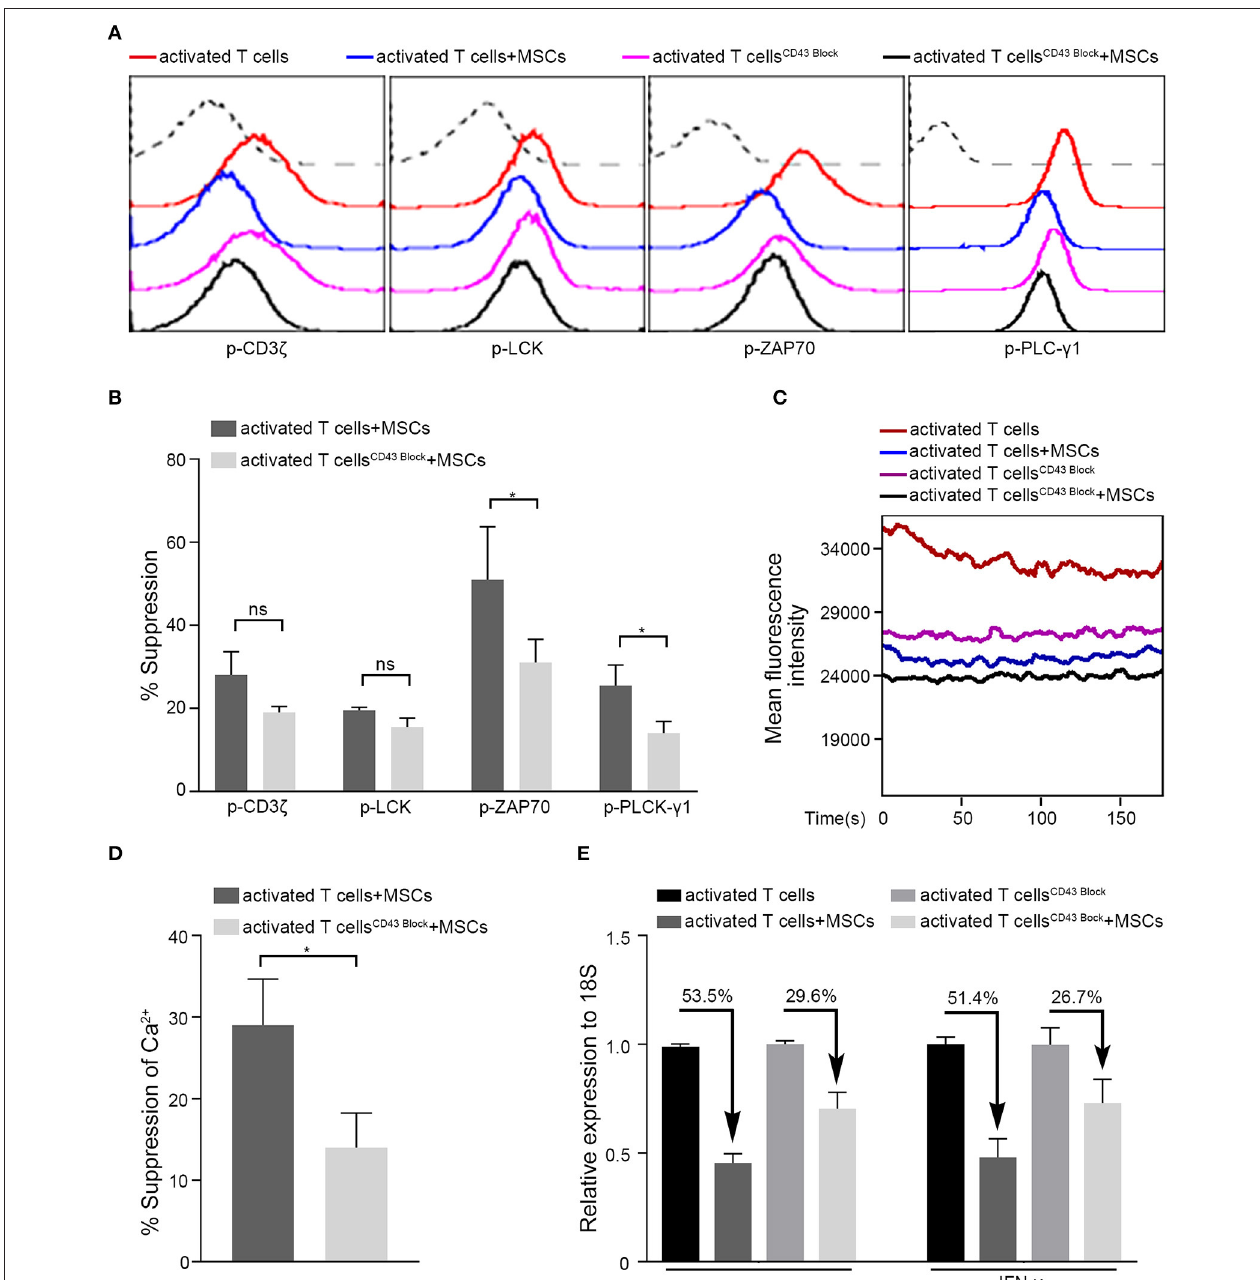
FIGURE 5 | MSCs exert rapid immunosuppressive actions on T cells through CD43. Four groups were analyzed: activated T cells with and without MSCs coculture, CD43-blocked activated T cells with and without MSCs coculture. (A) The phosphorylation levels of CD3 ζ , LCK, ZAP70, and PLC- γ 1 in activated T cells of the four groups above, the dotted curve represents isotype. (B) Bar graphs show the suppression percentages of p-CD3 ζ , p-LCK, p-ZAP70, and p-PLC- γ 1. Comparison is between activated T cells cocultured with MSCs and CD43-blocked activated T cells cocultured with MSCs. (C) Cytosolic Ca 2 + levels in activated T cells of the four groups were tested by flow cytometry. (D) The suppression percentages of the two MSCs-cocultured groups described in (B) are shown. (E) Quantitative reverse transcription–polymerase chain reaction (qRT-PCR) analysis of TNF- α and IFN- γ mRNA expressions in activated T cells from the four groups. The percentages of decrease after cocultured with MSCs are shown. All experiments were repeated three times. Data are presented as the mean ± SEM for each group. Significant differences are indicated as follows: ns, no statistical significance; * p < 0.05.